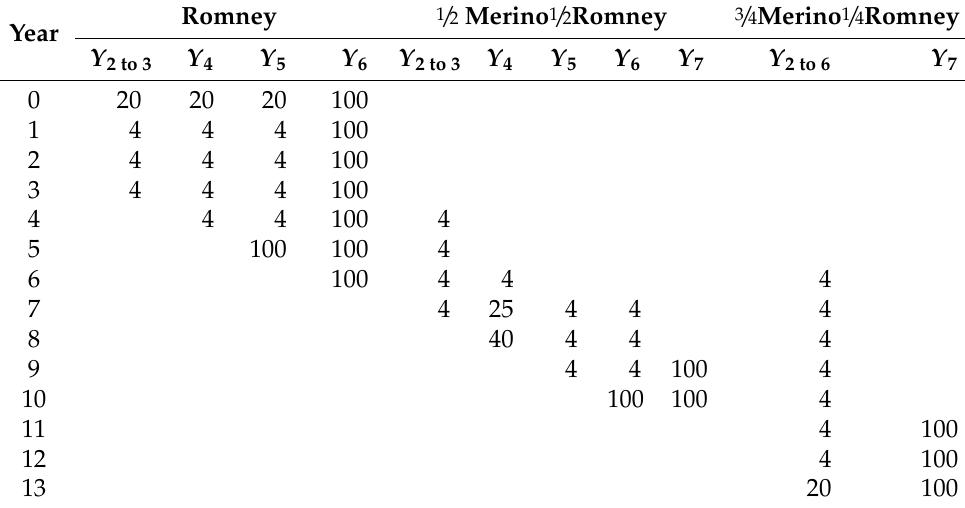
Table 3. Culling rates (%) for ewe of various age ( i ) classes ( Y i ) and breeds during a grading up transition. Culling rates are only presented when ewes of the age class are on farm, for example, Romney ewes were not replaced from year one onwards so there were no Romney ewes in Y 2 to 3 after three years of transition.